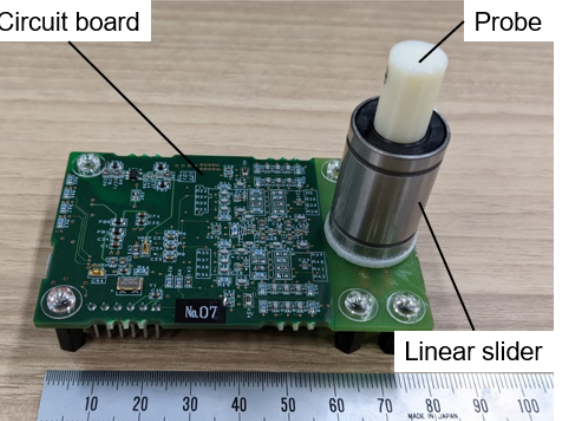
Figure 2. Prototype of the texture sensor. The circuit board includes an amplifier circuit and a microcomputer with AD conversion